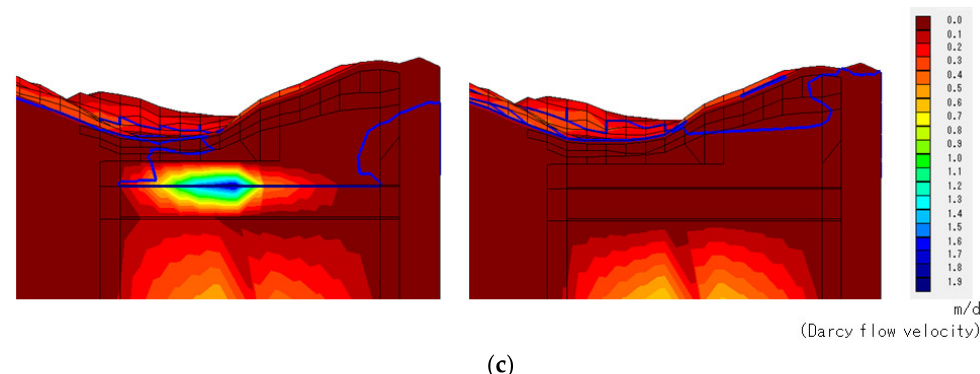
Figure 8. Vertical section of simulation model and simulated results of groundwater flow. ( a ) Vertical section of simulation model. ( b ) Distribution of total heads before (left) and after backfilling (right). ( c ) Distribution of Darcy flow velocity before (left) and after backfilling (right).